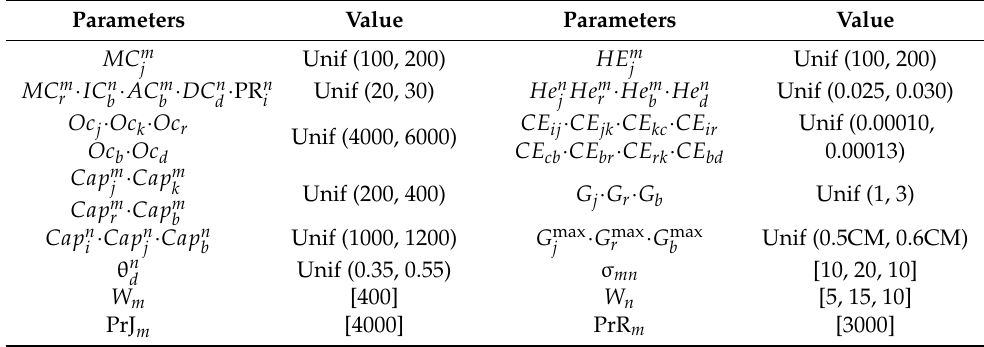
Table 3. The other parameters subject to Uniform distribution in the SCLSC